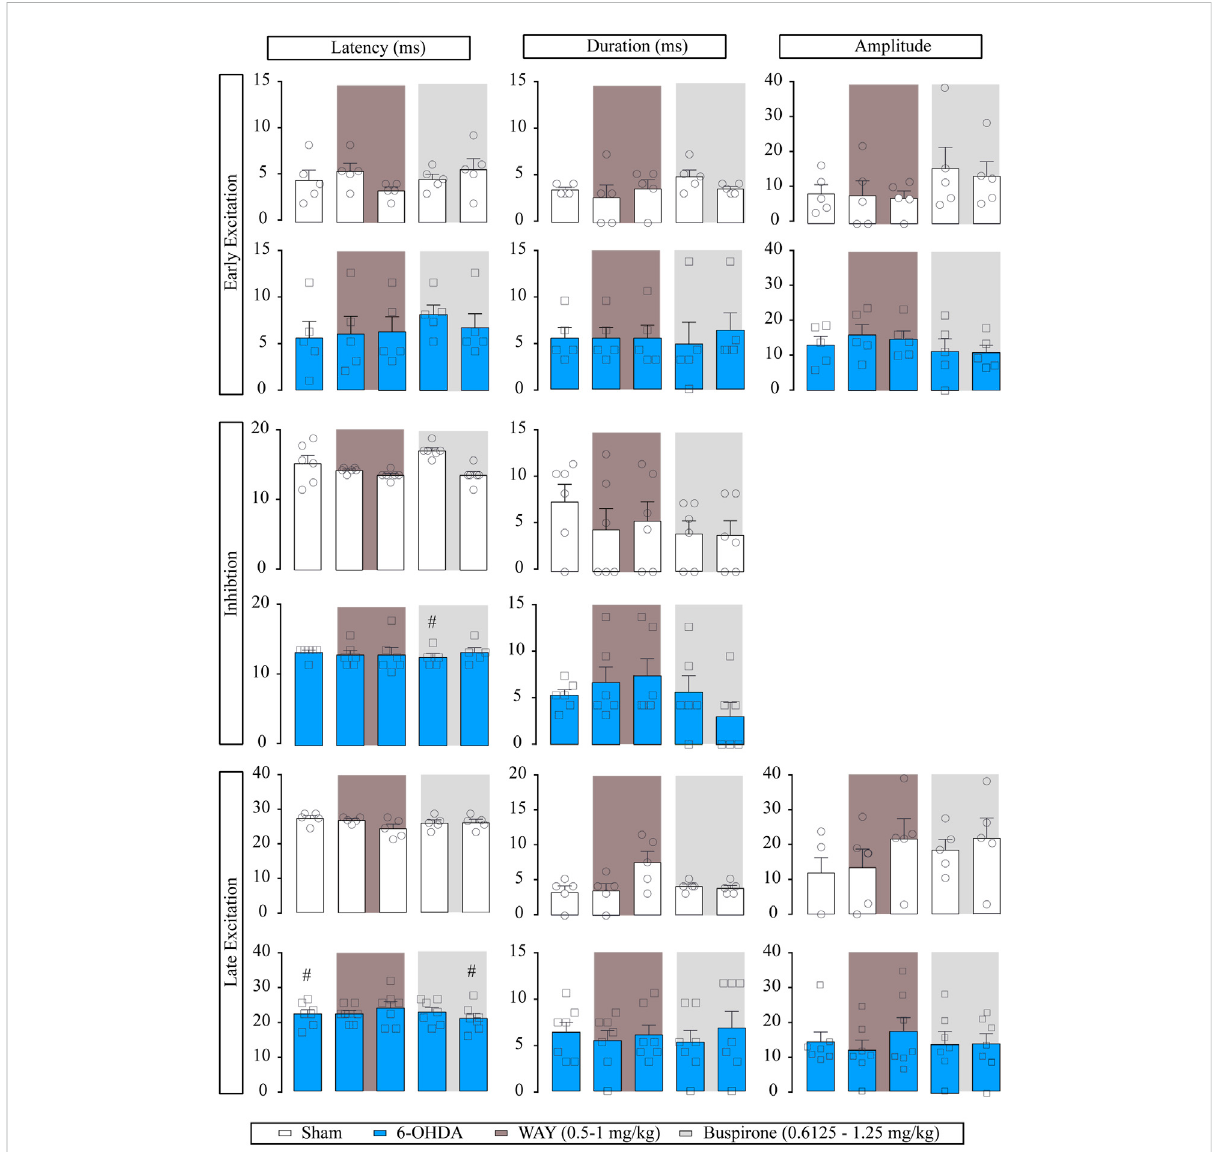
FIGURE 4 Effect of thesystemic administration ofWAY-100635 on motor cortico-nigralinformation.Representation ofcharacteristicparametersrelated to cortically evoked responses (latency, duration, and amplitude of the responses). The latency, duration and amplitude of the early excitatory componentareonthetop(sham n =5,6-OHDA n =6).Thelatencyanddurationoftheinhibitorycomponentareinthemiddle(sham n =6,6-OHDA n = 6). The latency, duration, and amplitude of the late excitatory component are on the bottom (sham n = 5, 6-OHDA n = 7). Each bar represents the mean ± SEM. Each dot represents the value from one neuron before and after WAY-100635 (0.5 – 1 mg/kg i.v.) and buspirone (0.6125 and 1.25 mg/kg, i. v.) in dark grey and in light grey. # p < 0.05 vs. sham (RM two-way ANOVA followed by Bonferroni ’ s post hoc